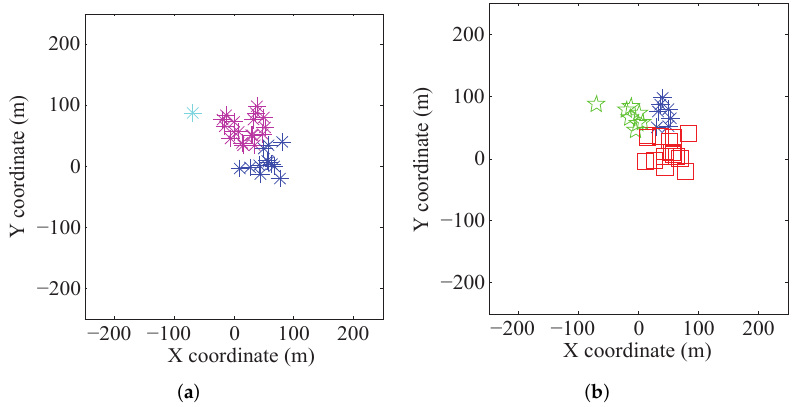
Figure 2. Sub-partitioning vs. prediction-driven measurement sub-partitioning. ( a ) The measurements are partitioned by sub-partitioning; ( b ) The measurements are partitioned by prediction-driven measurement